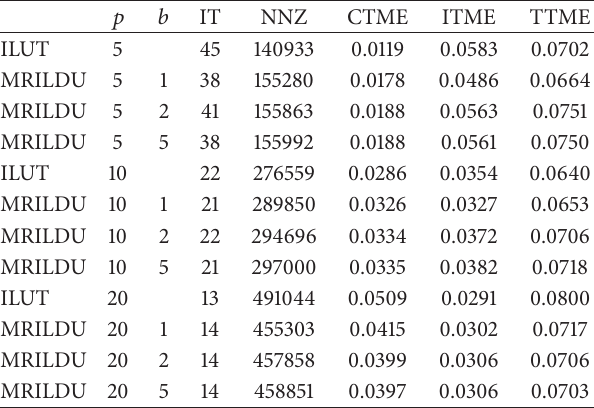
Table 6: Iteration results for matrix airfoil 2d.